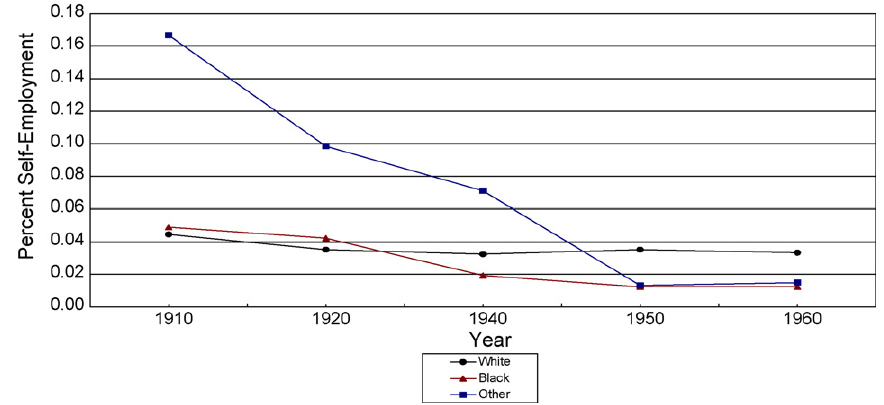
Fig. 1. U.S. non-immigrant, self-employment rates—Northeast region: 1910–1960.